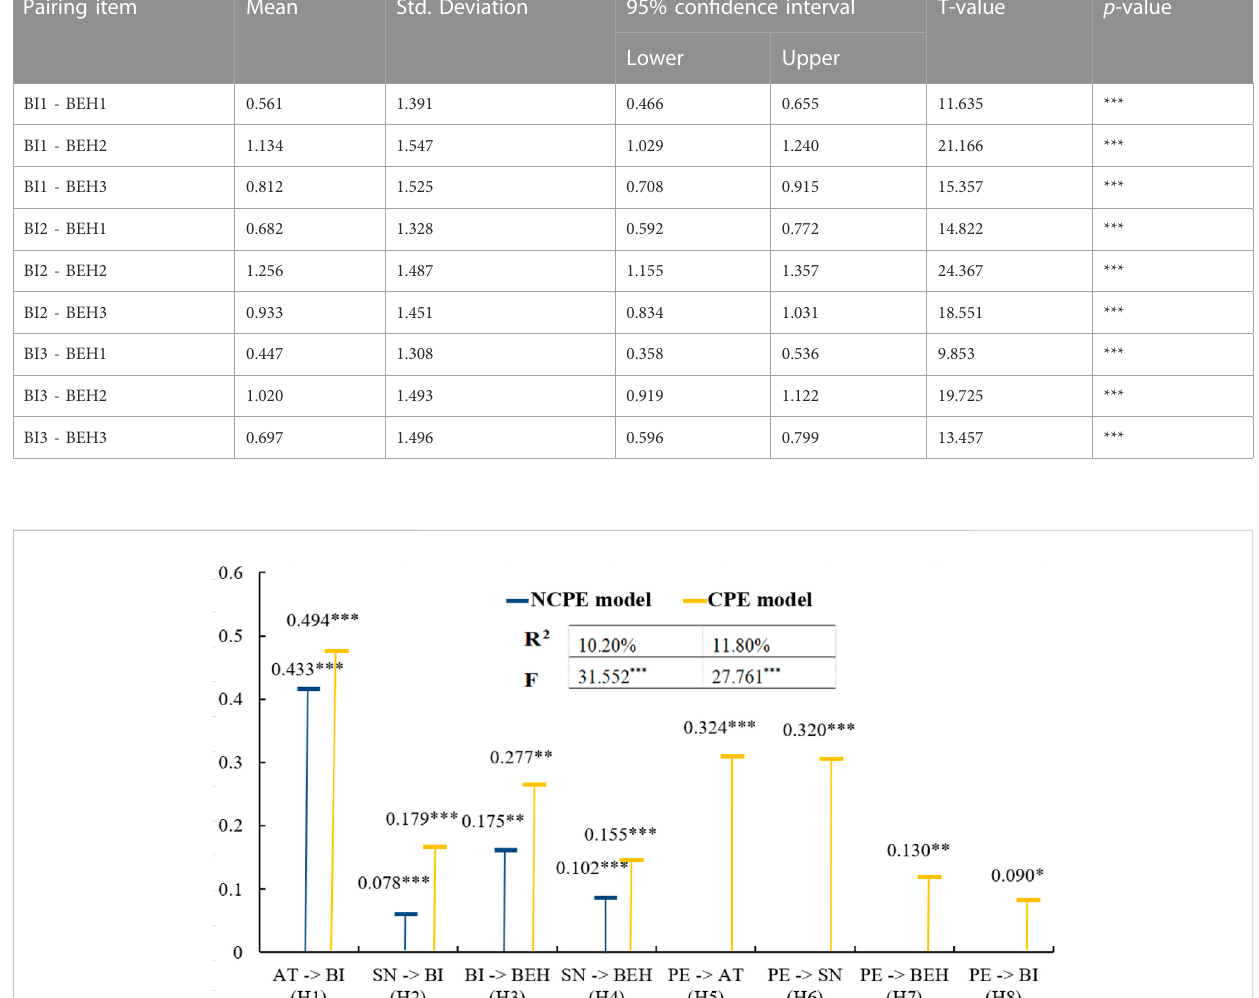
TABLE 4 Paired sample t -test. Pairing